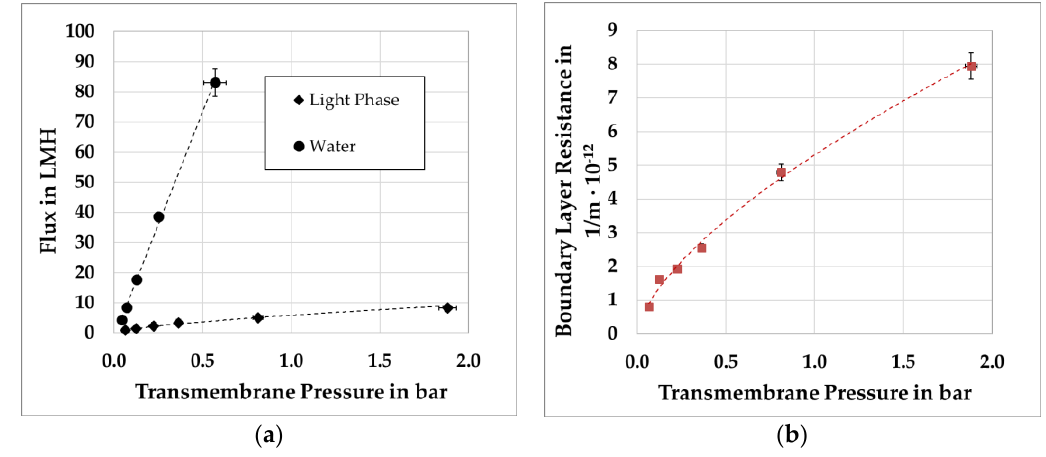
Figure 7. ( a ) Comparison flux vs. transmembrane pressure. ( b ) Development of boundary layer resistance.